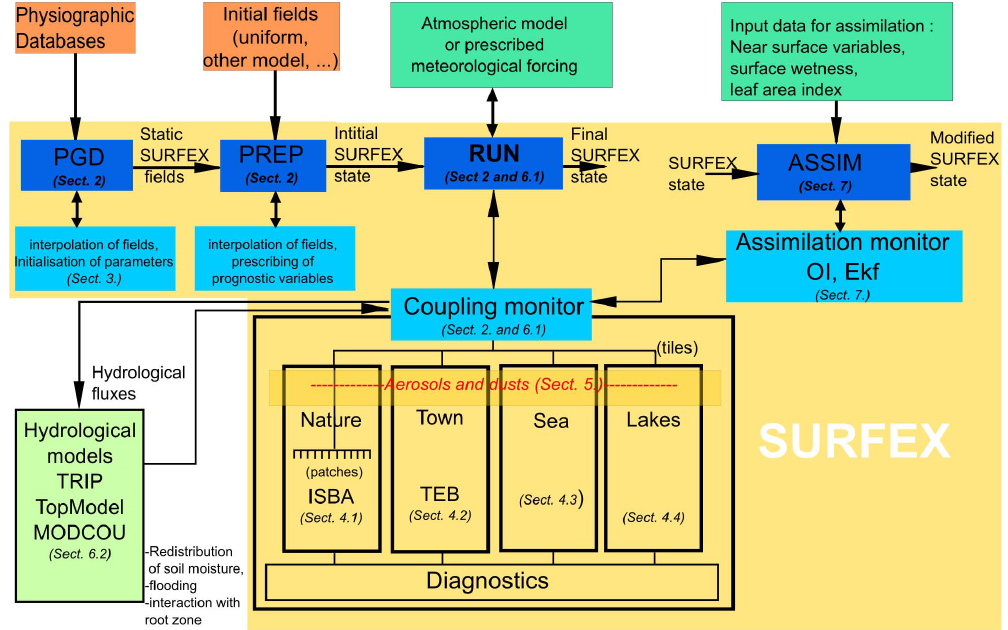
Fig. 2. Schematic representation of the main scientific and technical components of SURFEX (on a yellow background) and their interaction with other models and data.